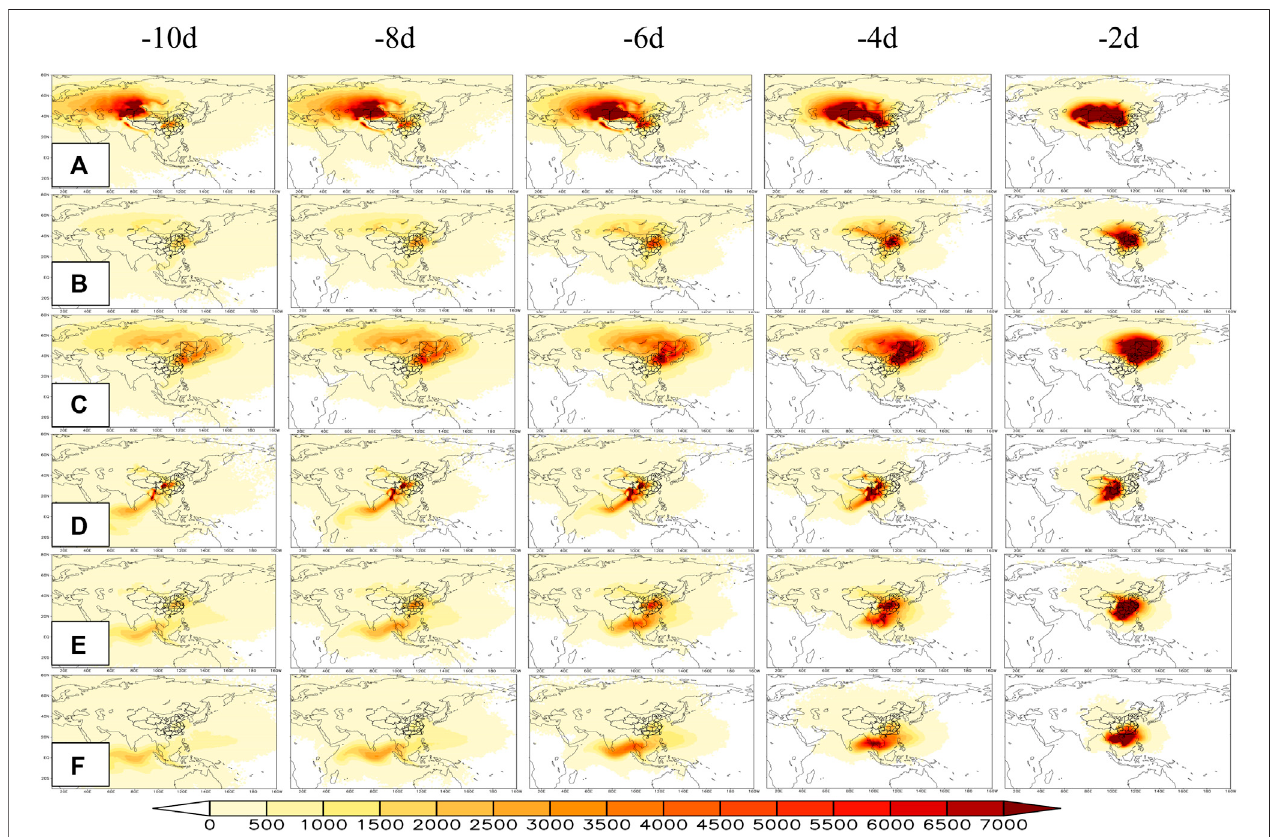
FIGURE 3 | Moisture trajectories of air parcels 10 (8, 6, 4, and 2) days before reaching the six subregions: (A) NW, (B) NC, (C) NE, (D) SW, (E) YRV, and (F) SC.